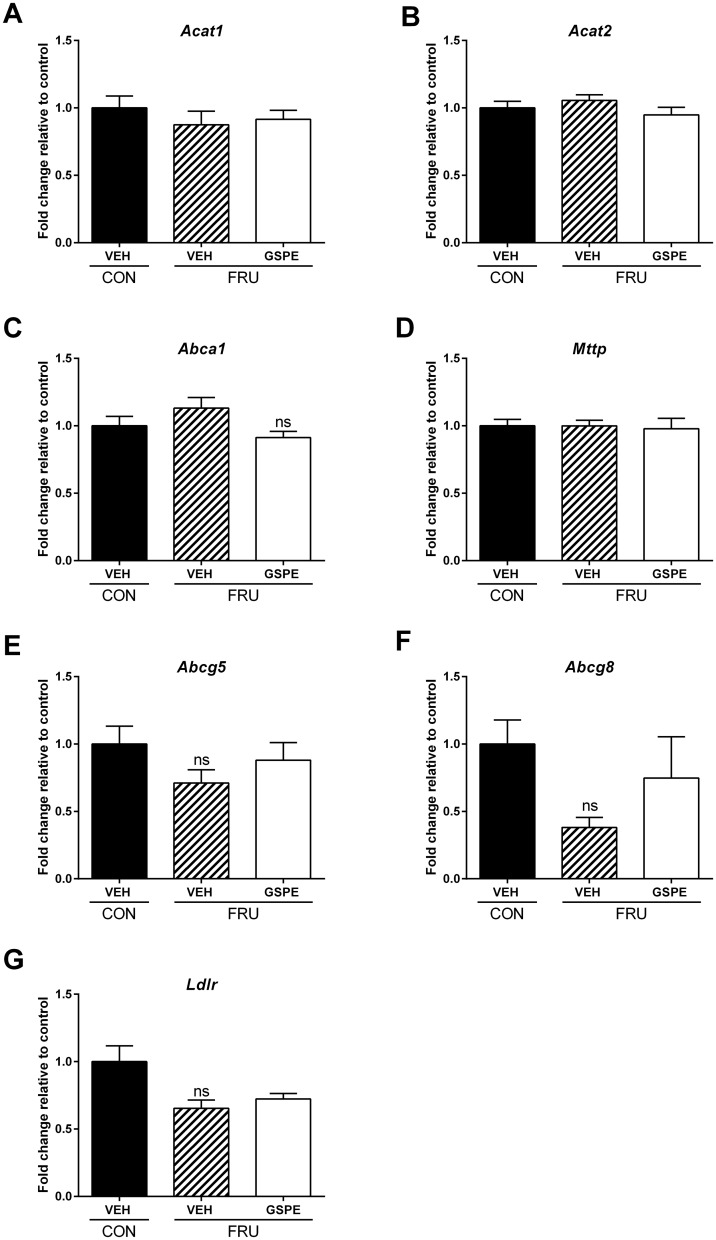
Hepatic expression of genes involved in hepatic cholesterol export.Gene expression changes were analyzed for (A) Acat1, (B) Acat2, (C) Abca1, (D) Mttp, (E) Abcg5, (F) Abcg8, and (G) Ldlr.